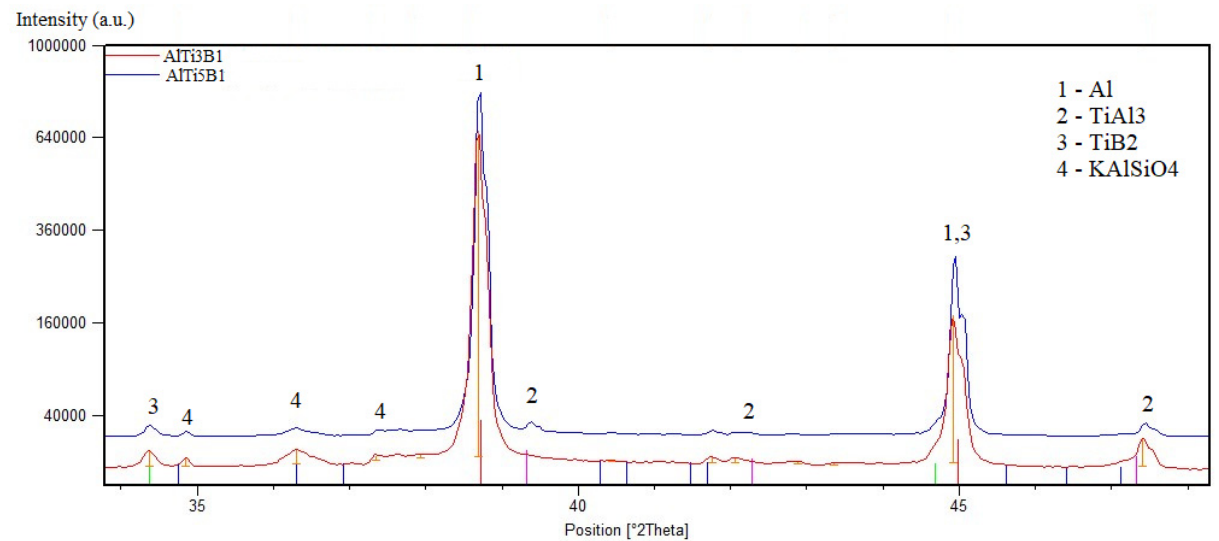
Figure 3. XRD patterns of AlTi3B1 and AlTi5B1 alloys.